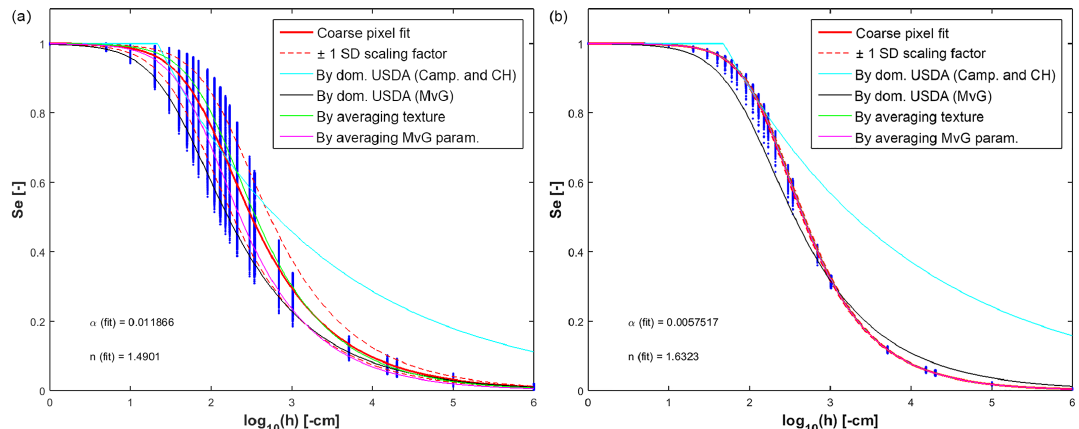
Figure 8. Retention curves for Lower Saxony (left) and North Rhine-Westphalia (right) calculated using different approaches. The coarse pixel fit is the result of the Warrick scaling approach, where (log 10 ˆ λ i ) was also estimated. Therefore, ± 1SD(log 10 ˆ λ i ) could also be provided to identify the sub-grid uncertainty. Further retention curves were calculated by dominant USDA class (both for Brooks and Corey with Clapp and Hornberger and for MvG equation), by averaging texture and by averaging MvG parameters. Blue points indicate S e at standard hydraulic heads for each individual